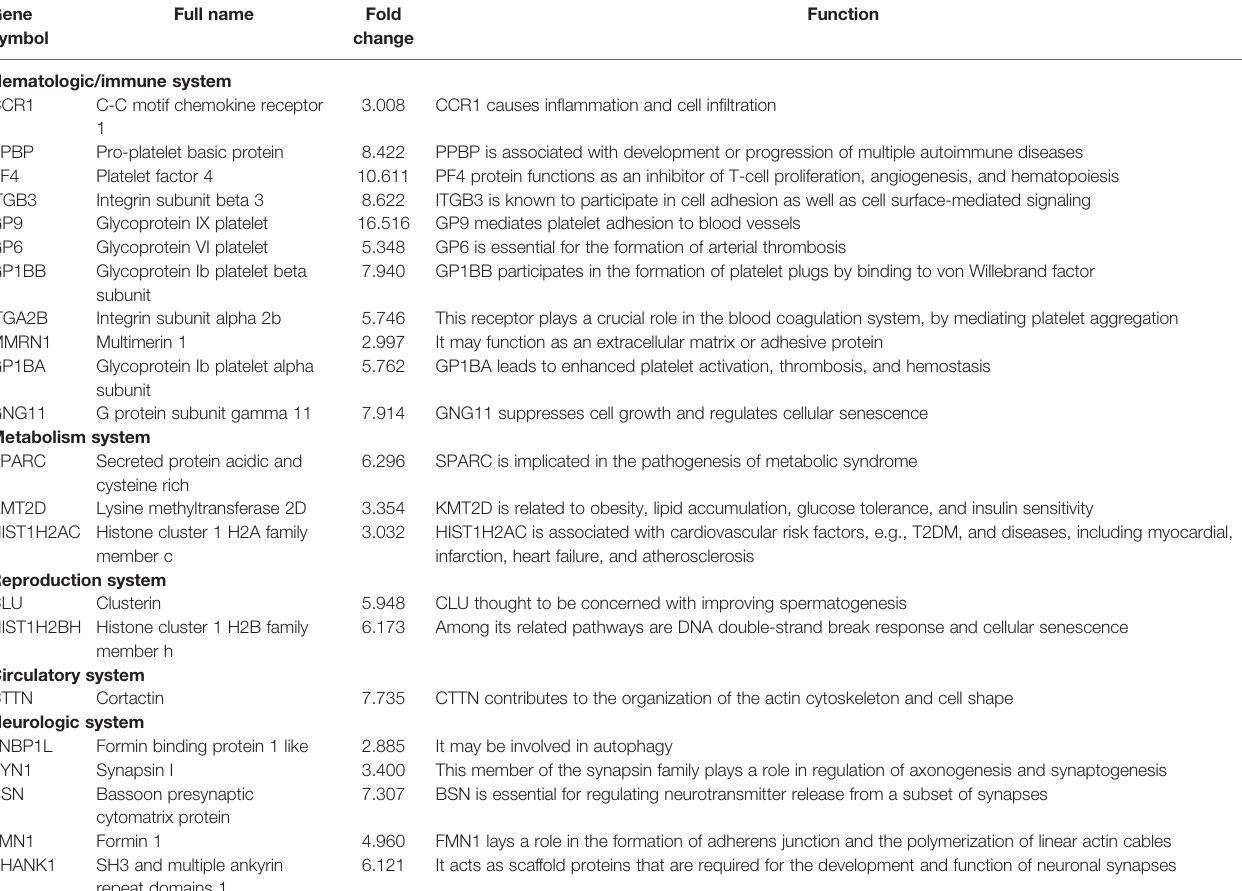
TABLE 4 | Functional roles of 22 genes of